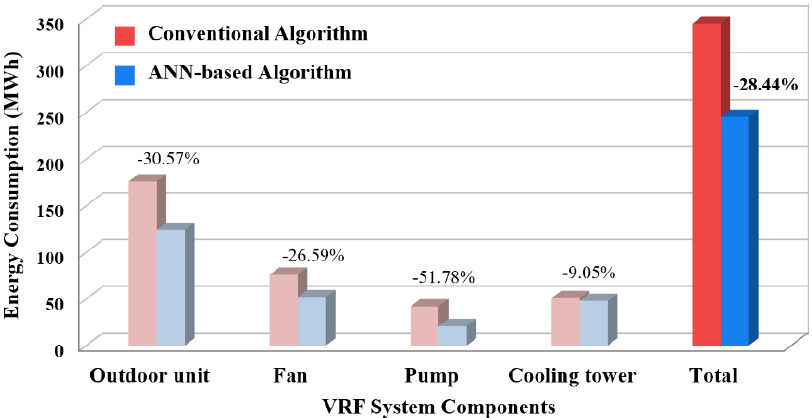
Figure 14. Cooling energy consumption comparisons between conventional and ANN-based control algorithms.